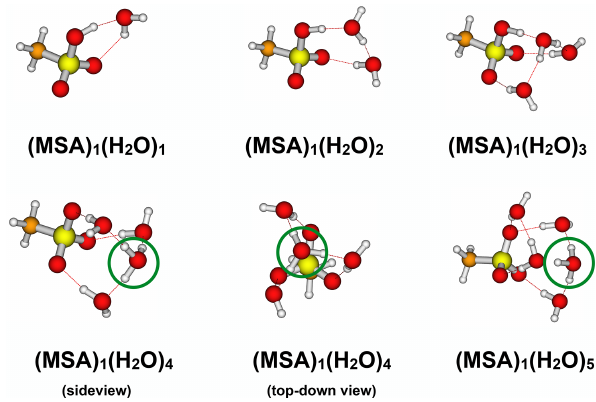
Figure 6. Identified lowest Gibbs free energy (MSA) 1 (H 2 O) 1 − 5 cluster structures calculated at the ω B97X-D/6-31++G(d,p) level of theory. The green circles indicate the formation of a H 3 O +